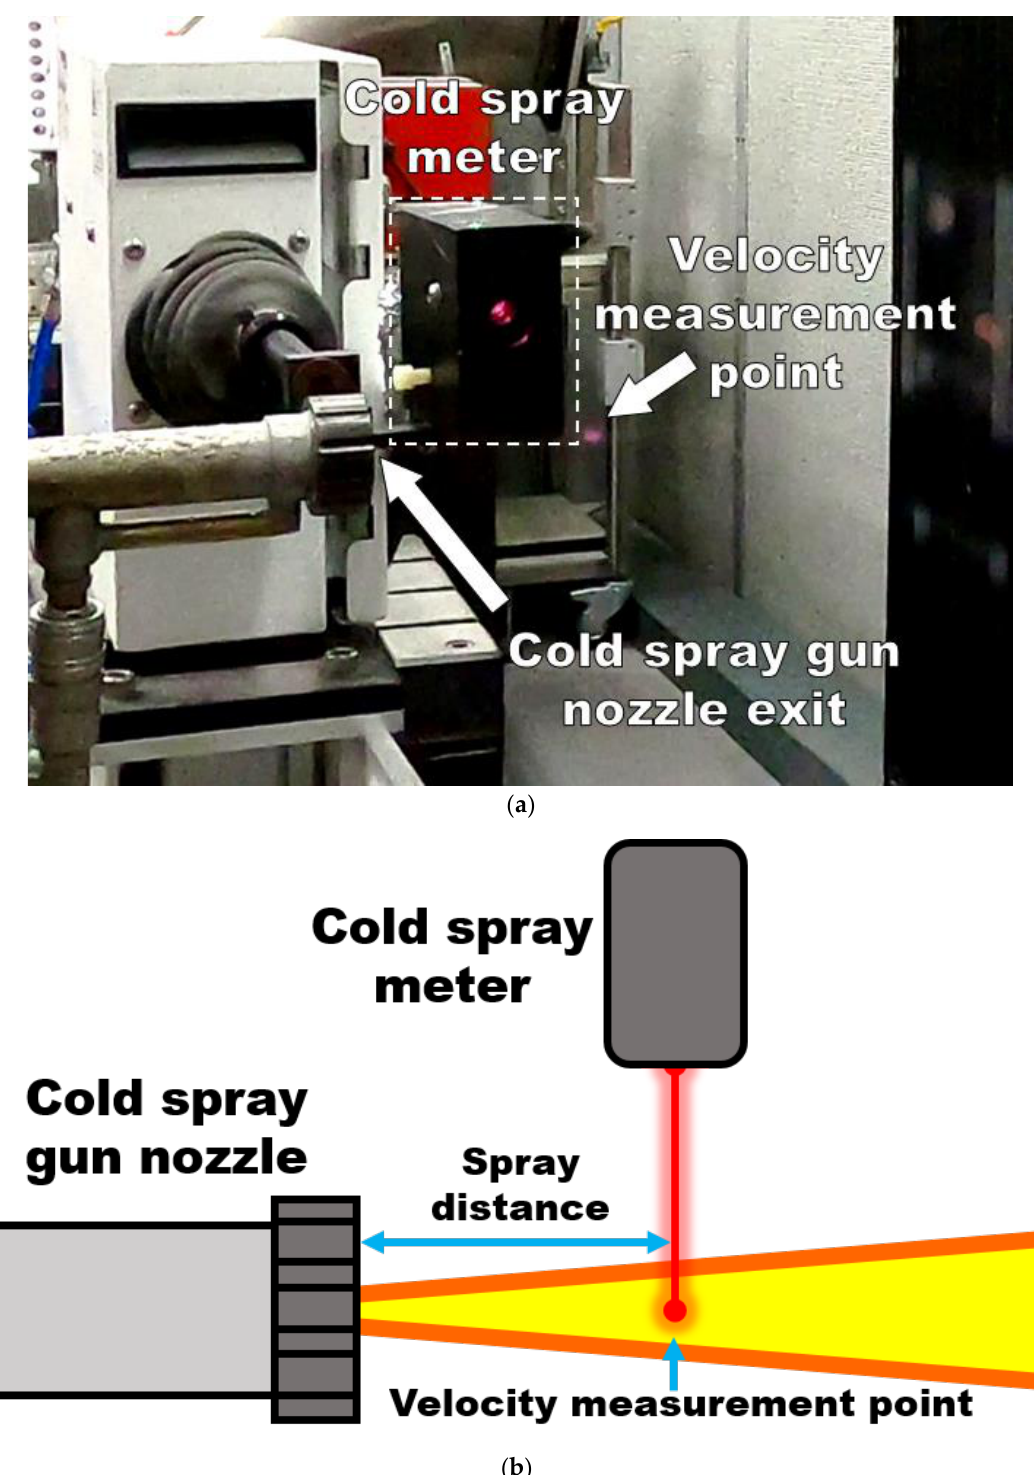
Figure 1. Position of the cold spray gun with respect to the cold spray meter during cold spray operation. The gun is placed perpendicularly to the cold spray meter measurement point and moved to the desired spray distance to perform velocity measurement. The spray distance is measured from the cold spray gun nozzle exit to the velocity measurement point as shown in ( a ) actual experimental setup and ( b ) illustration.